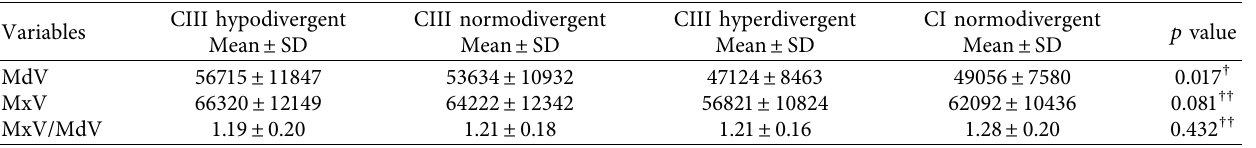
Table 3: Descriptive statistics of the maxillary volume, mandibular volume, the ratio between the two volumes (MxV/MdV), and the p value of significance